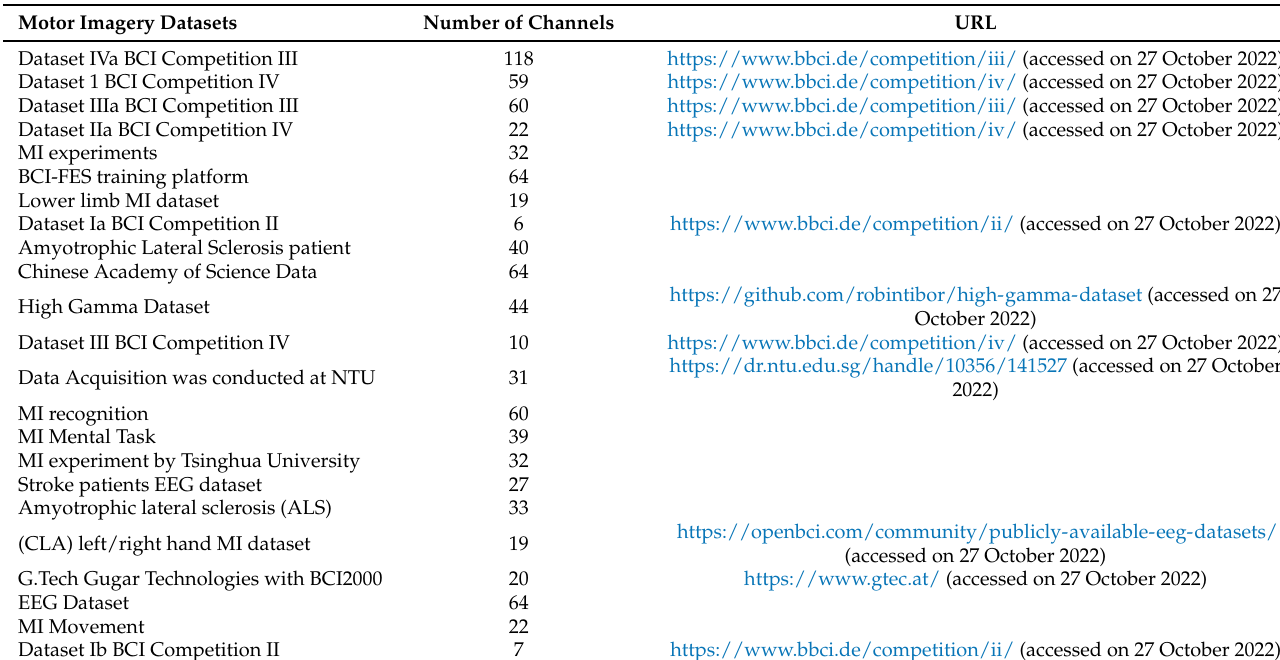
Figure 4. Percentage of different datasets. Table 1. Motor Imagery EEG